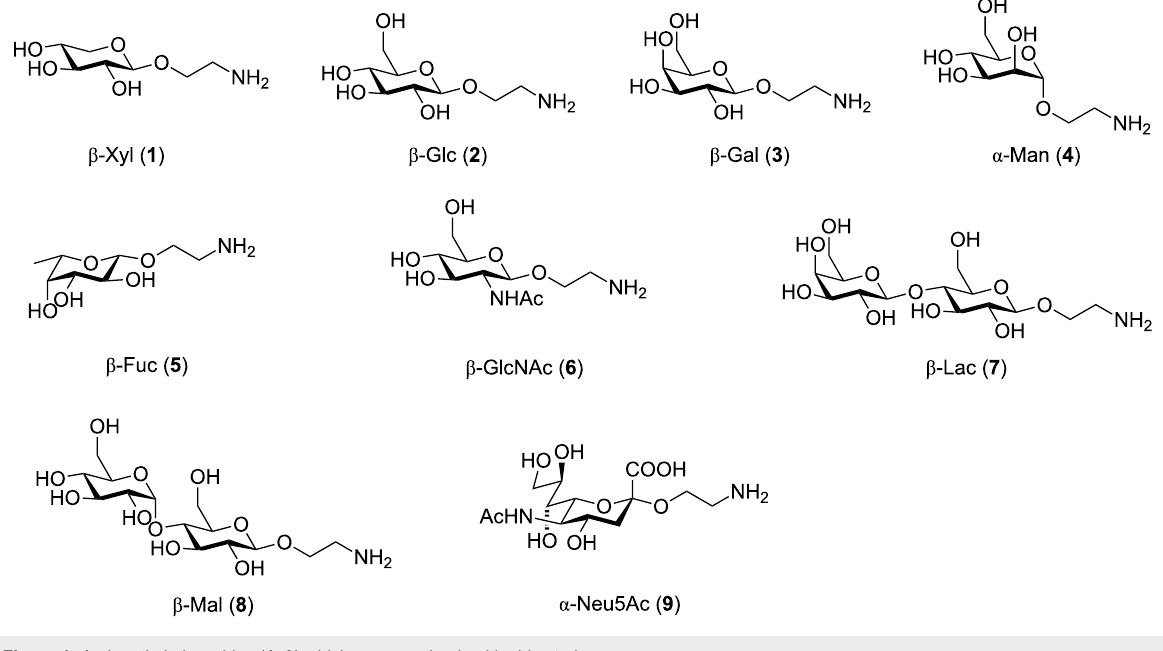
Figure 1: Aminoethyl glycosides ( 1 – 9 ) which were synthesised in this study.